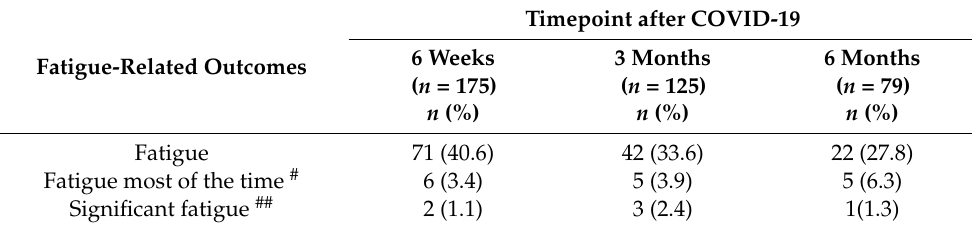
Table 2. Prevalence over time of fatigue after COVID-19 was diagnosed during pregnancy at each time point after infection (G1, n =